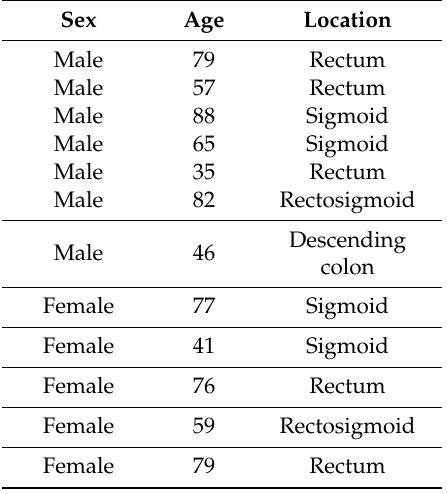
Table 1. Information on 12 colorectal cancer (CRC)